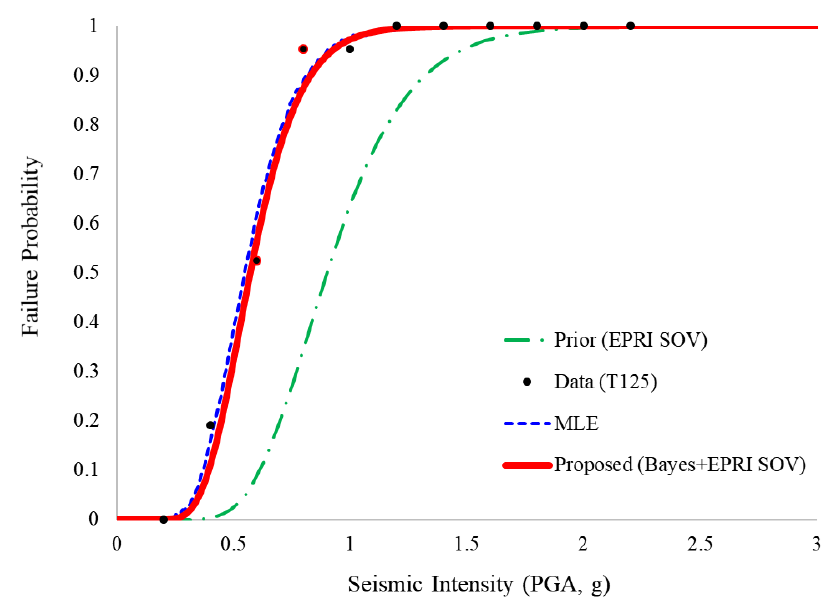
Figure 11. Piping seismic fragility curve regarding a limit state of seismically vulnerable T-joint T125. Appl. Sci. 2020 , 10 , x FOR PEER REVIEW